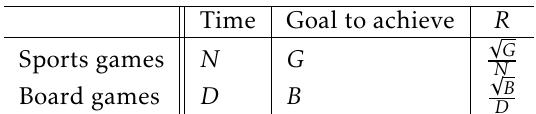
Table 1. Game progress factors and game refinement value for various